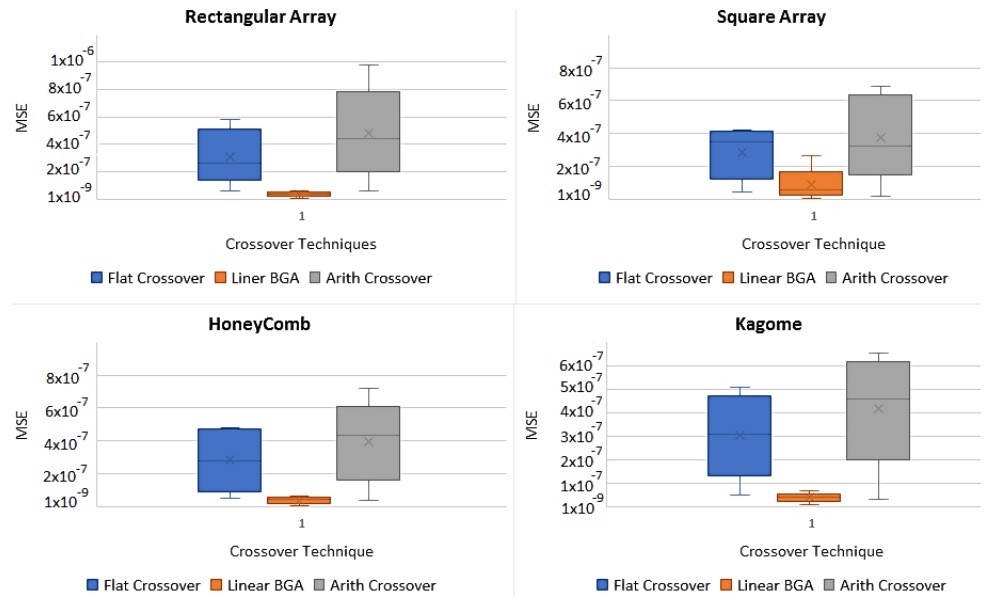
Figure 5. MSE comparison of various cross-over techniques on the selected geometries.